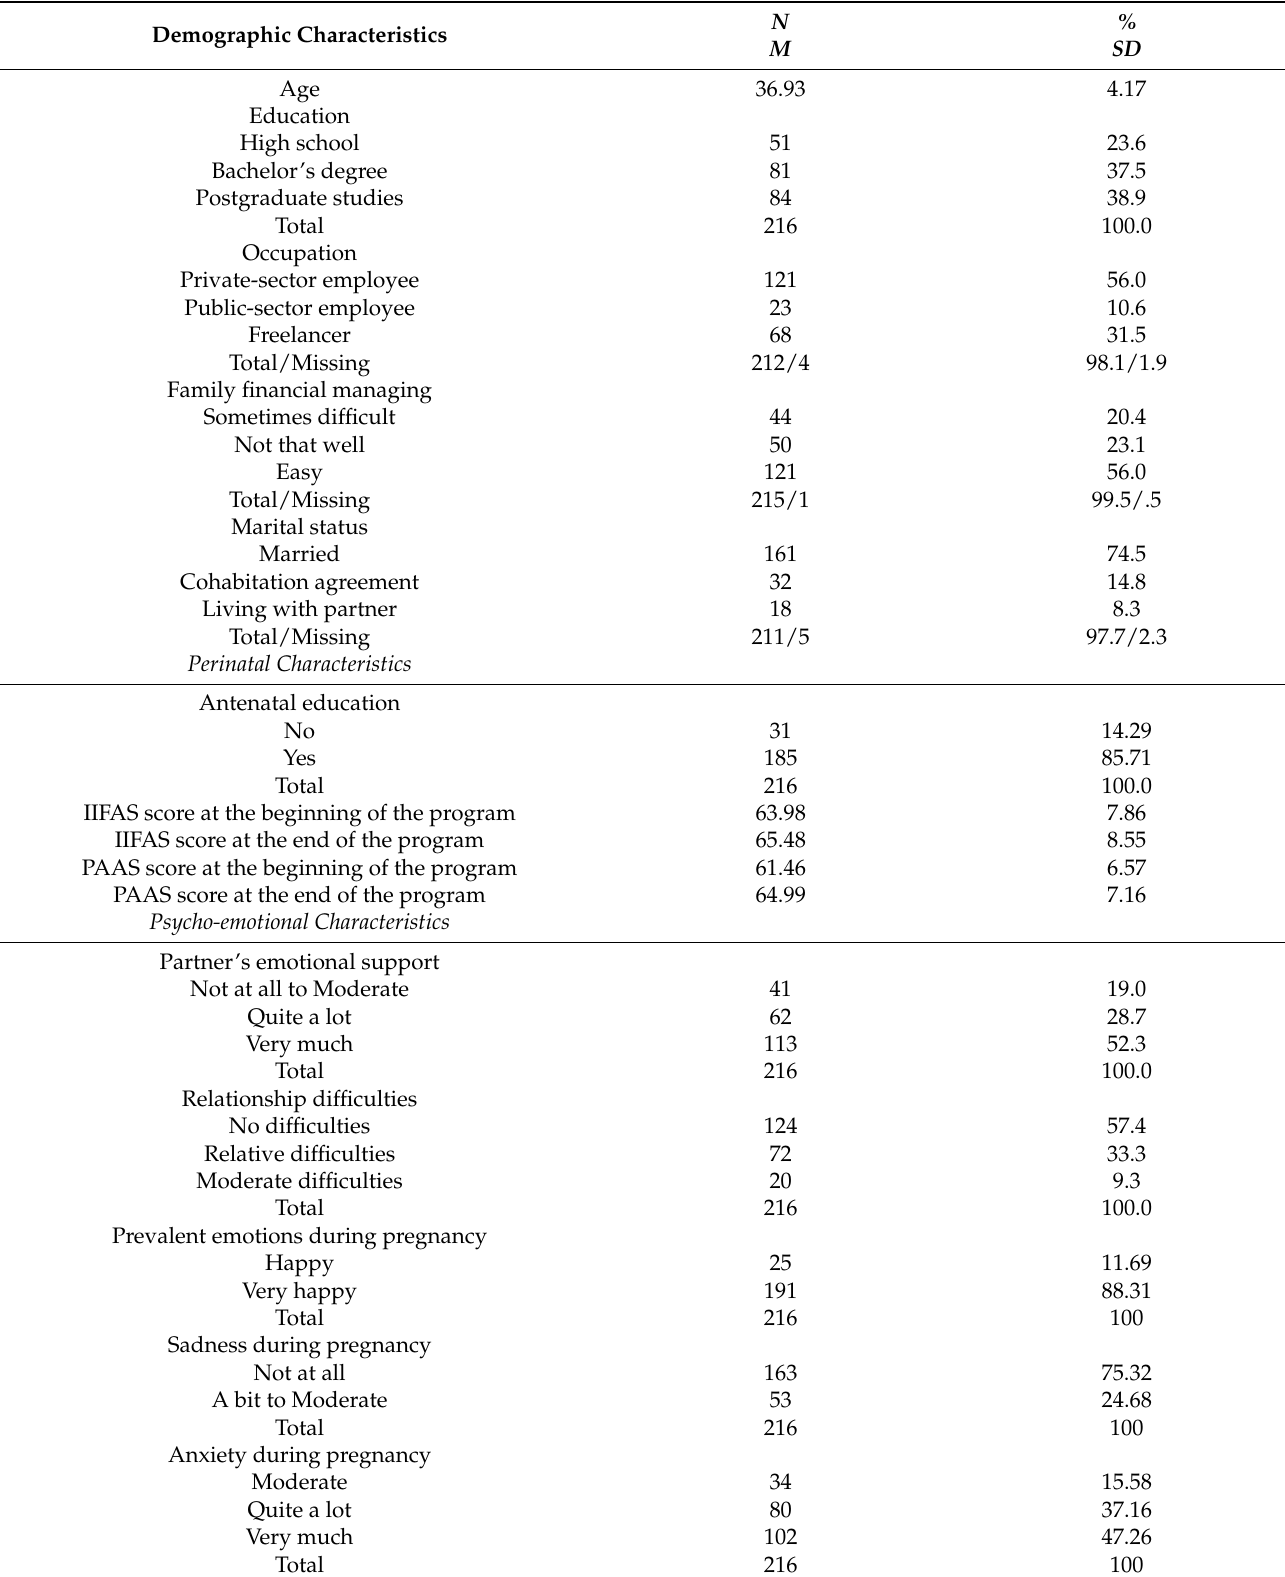
Table 1. Expectant Fathers’ Demographic, Perinatal and Psycho-emotional